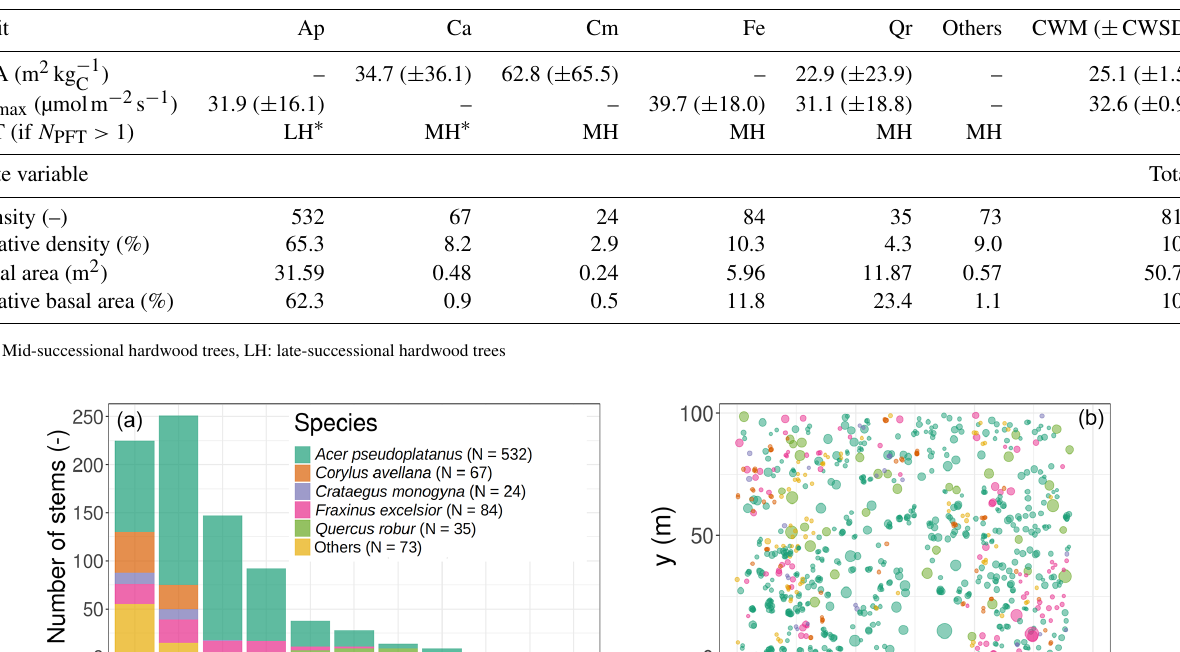
Table 1. Mean values ( ± 1 standard deviation) of plant traits (specific leaf area (SLA) and maximum rate of carboxylation ( V c , max )) available in the TRY database for each of the five dominant species in Wytham Woods, and the local prevalences of those species (in terms of individual density and basal area). Missing traits were unavailable in TRY. The table also summarises the abundances of those five dominant species in the 1.4ha plot in terms of absolute and relative density and basal area, as well as the PFT mapping when more than one PFT was simulated ( N PFT > 1). The community-weighted means (CWM) and standard deviations (CWSD) were obtained using the basal areas as weights. Ap: Acer pseudoplatanus , Ca: Corylus avellana , Cm: Crataegus monogyna , Fe: Fraxinus excelsior , and Qr: Quercus robur .